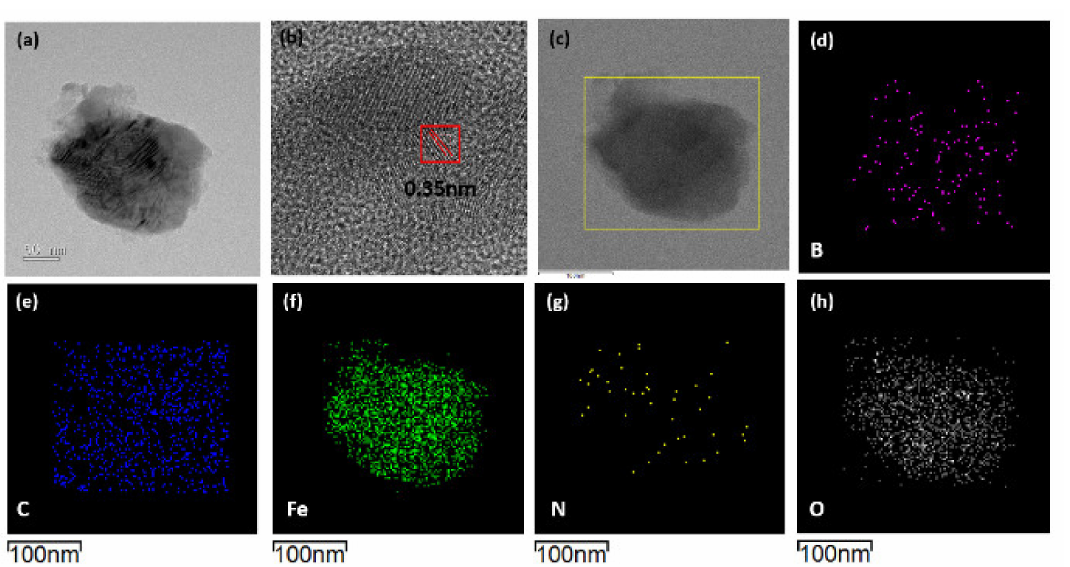
Figure 2. The morphology and chemical composition of the as-prepared iron borate: ( a , b ) low-resolution ( a ) and high- resolution ( b ) TEM images; ( c ) STEM image, and ( d – h ) corresponding EDX mapping images for the elements B, C, Fe, N, and O. EDX mapping images were taken within the yellow square in Figure